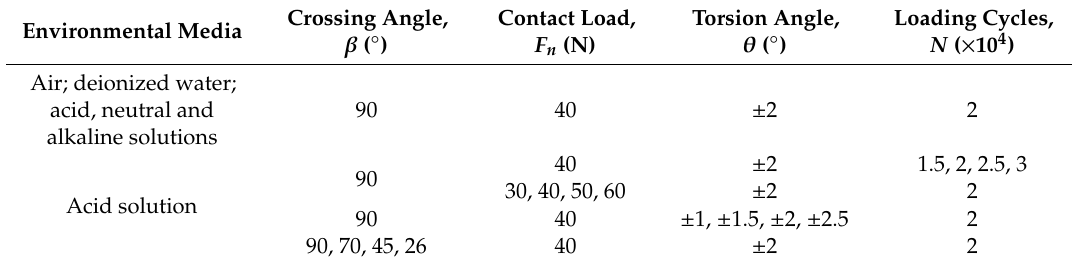
Table 2. Environmental media and tension–torsion cyclic loading test